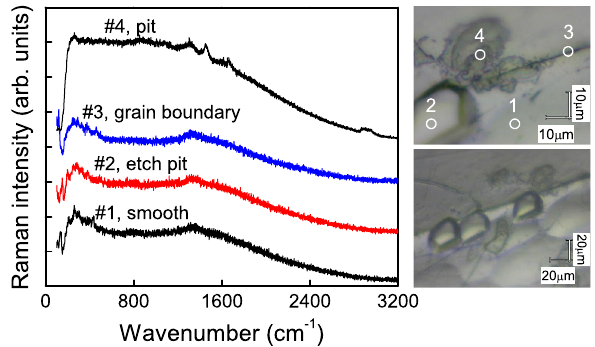
FIG. 1. The right panel shows two optical images of a region near grain boundary with high density of etch pits on Jlab #9. The left panel shows corresponding Raman spectra of circled